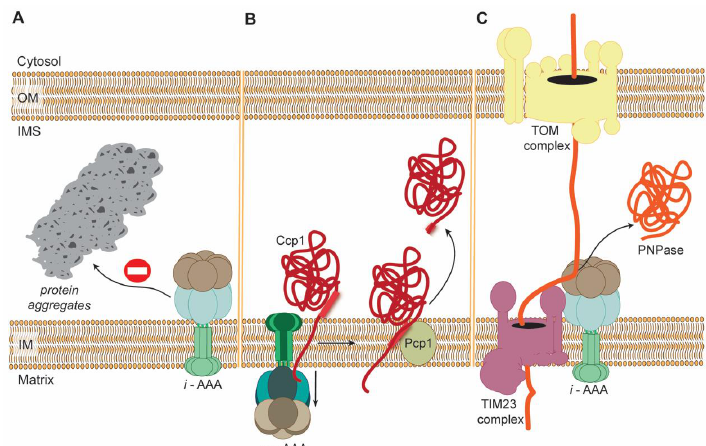
Figure 2. Examples of actions of yeast AAA proteases that are independent of their proteolytic activity. ( A ) i -AAA protease prevents aggregation of misfolded intermembrane space proteins through chaperone-like activity. ( B ) m -AAA dislocates precursor of Ccp1 from the mitochondrial inner membrane (IM) enabling its cleavage by the rhomboid protease Pcp1. The membrane